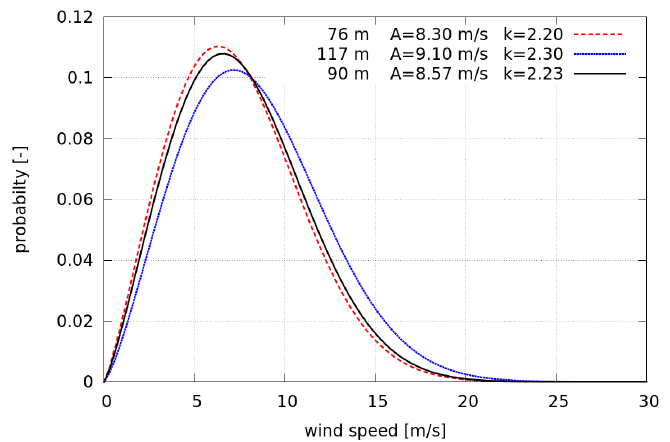
Figure 13. Wind speed distribution at two different heights of the Risø met mast [30] and interpolated wind speed distribution at 90 m.